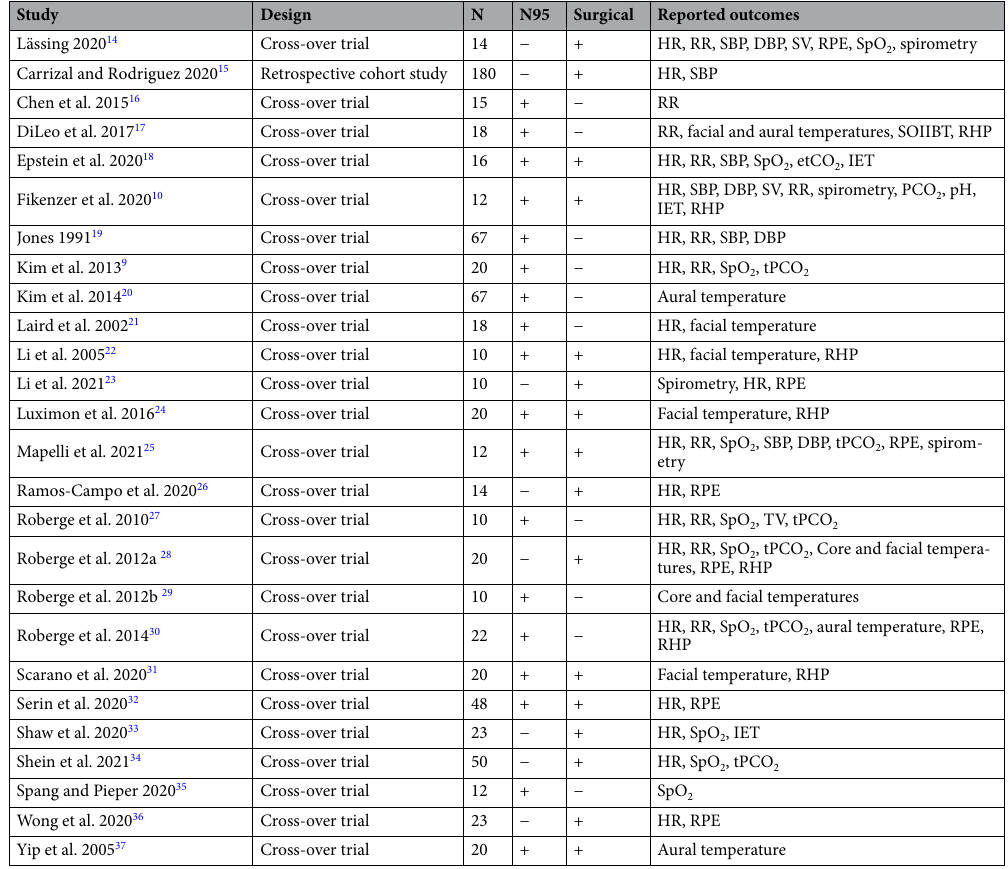
Table 1. Characteristics of the included studies; HR heart rate, RR respiratory rate, SpO 2 pulsoxymetrically measured oxygen saturation, tPCO